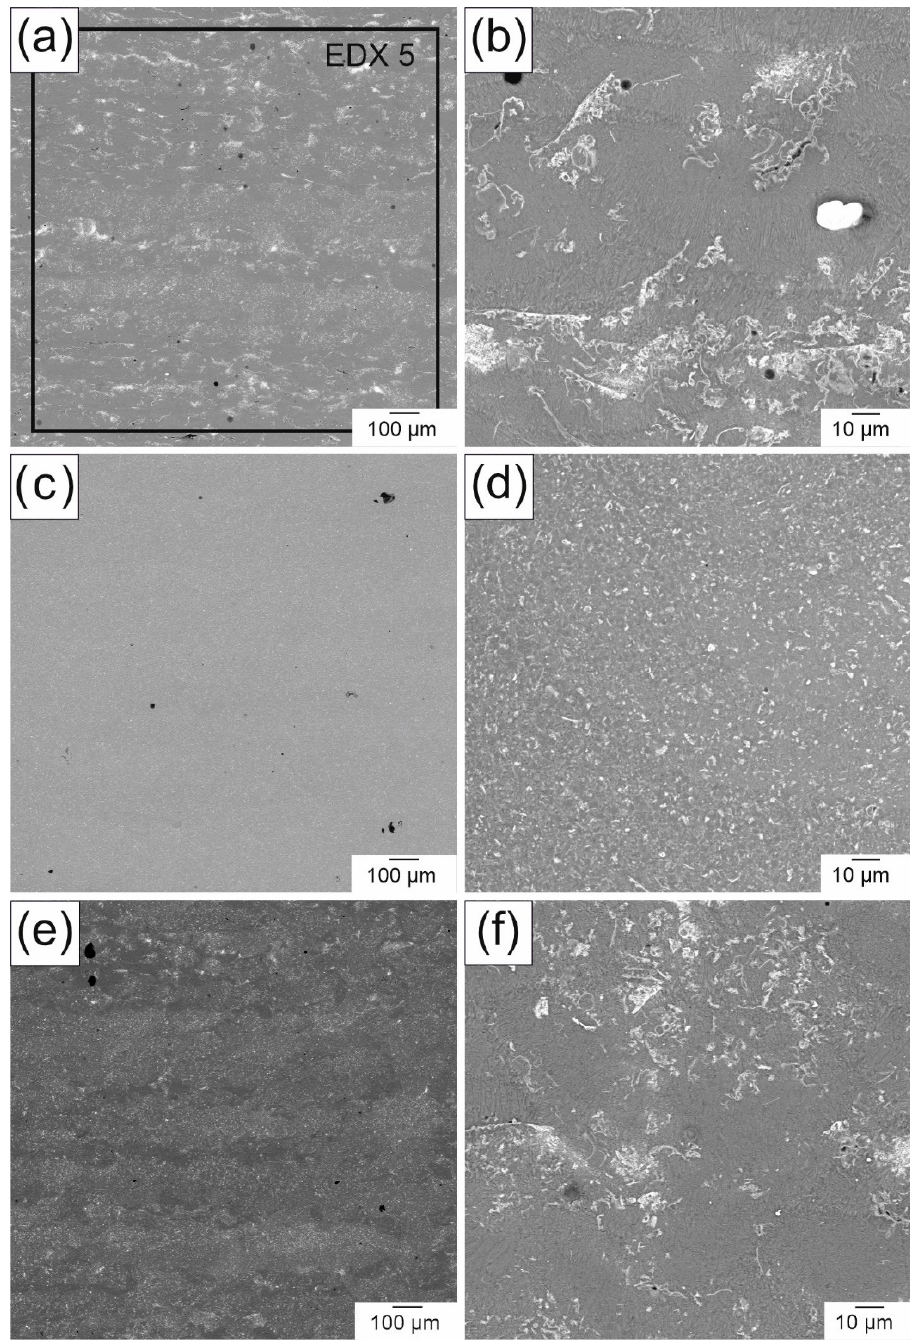
Figure 8. Backscattered electron images of PBF-LB-generated WE43: ( a , b ) sample for the porous bending test and ( c – f ) sample for the compression test.